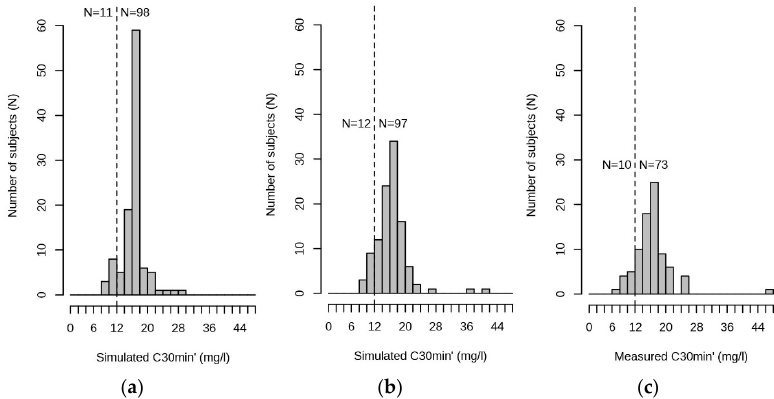
Figure 4. Distribution of the simulated and measured C (30 min’) values. ( a ) Simulated at population level; ( b ) simulated at individual level. ( c ) Measured concentrations within 1 h after infusion stops (available from 83 patients). Vertical broken line shows the recommended maximal C (30 min’) for long-duration treatment (12 mg/L). N , numbers of patients with C (30 min’) below 12 mg/L (left to the broken line), and above 12 mg/L (right to the broken line).